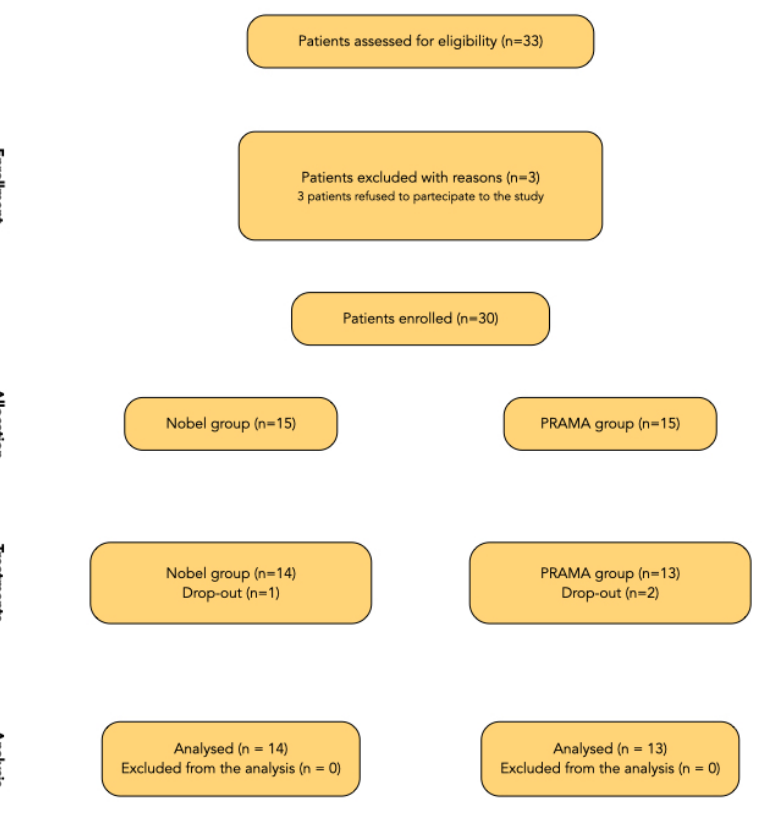
Figure 5. Flow chart. Table 4. Baseline characteristics between